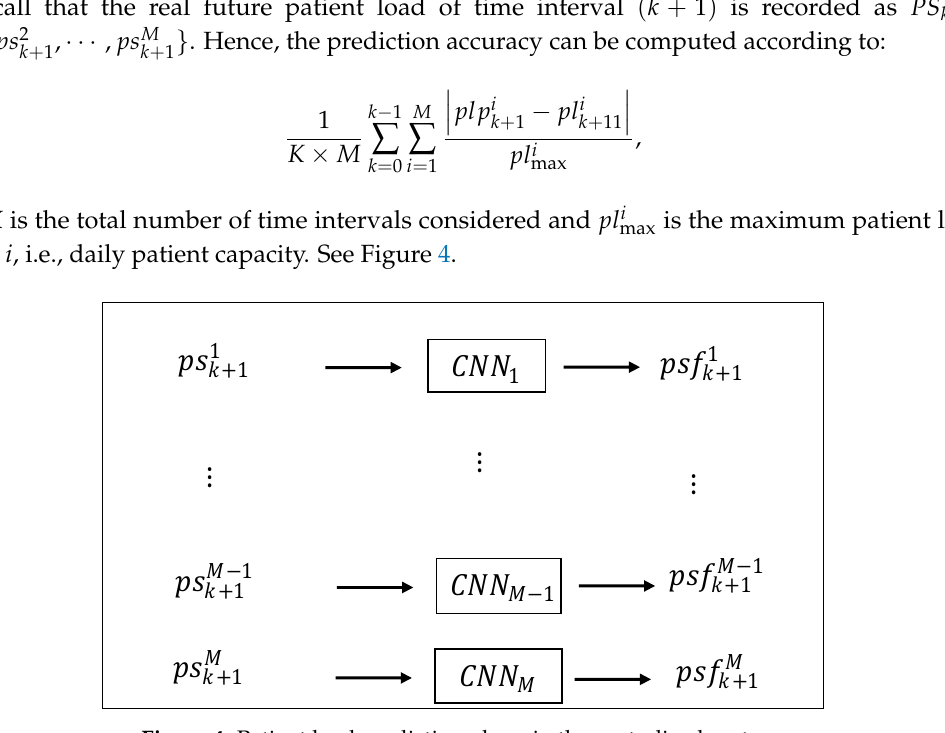
Figure 4. Patient load prediction phase in the centralized